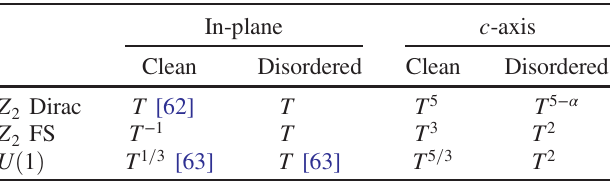
= ð π þ Δ , with Δ the A A Þ A